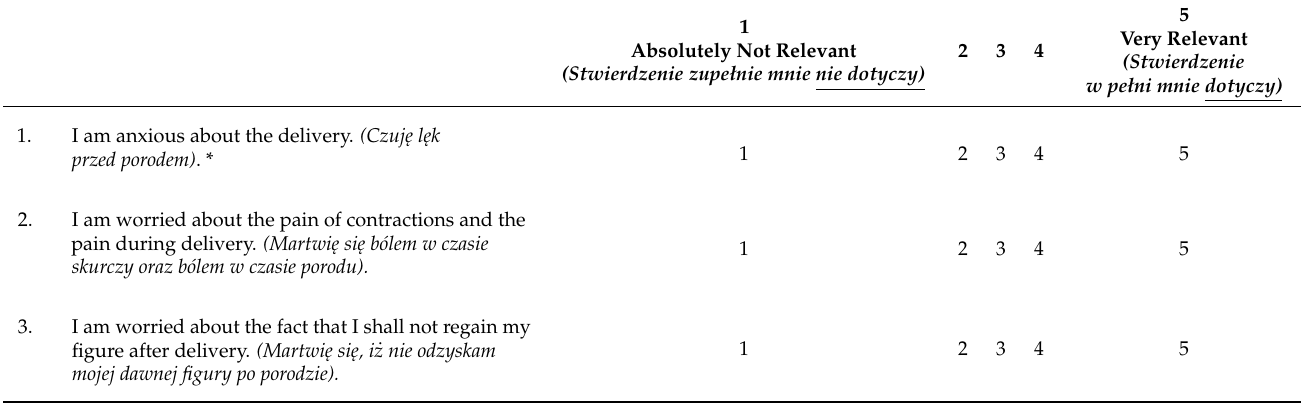
Table A1. PRAQ-R/R2 form used in comparative study (original and translated items presented together). Please circle each answer that applies most accurately to your situation. (Zaznacz odpowied´z, kt ó ra najlepiej pasuje do Twojej sytuacji.) Answer categories: (Kategorie